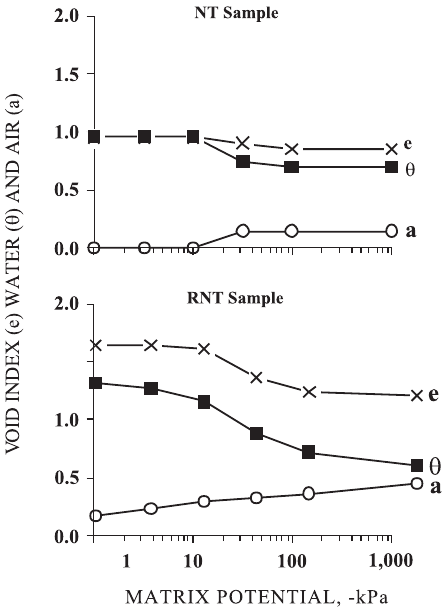
Figure 2. Index of voids (e), water ( θθθθθ ) and air (a), average of five repetitions of clusters aggregates of 4 to 5 mm in diameter, of Oxisol under NT (no-till without crop rotation) and RNT (no till with crop